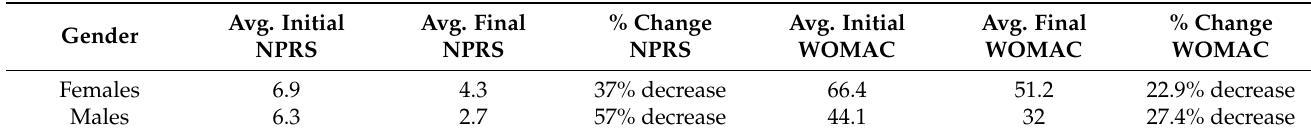
Table 3. Percent change analysis for females and males based on initial and final NPRS and WOMAC